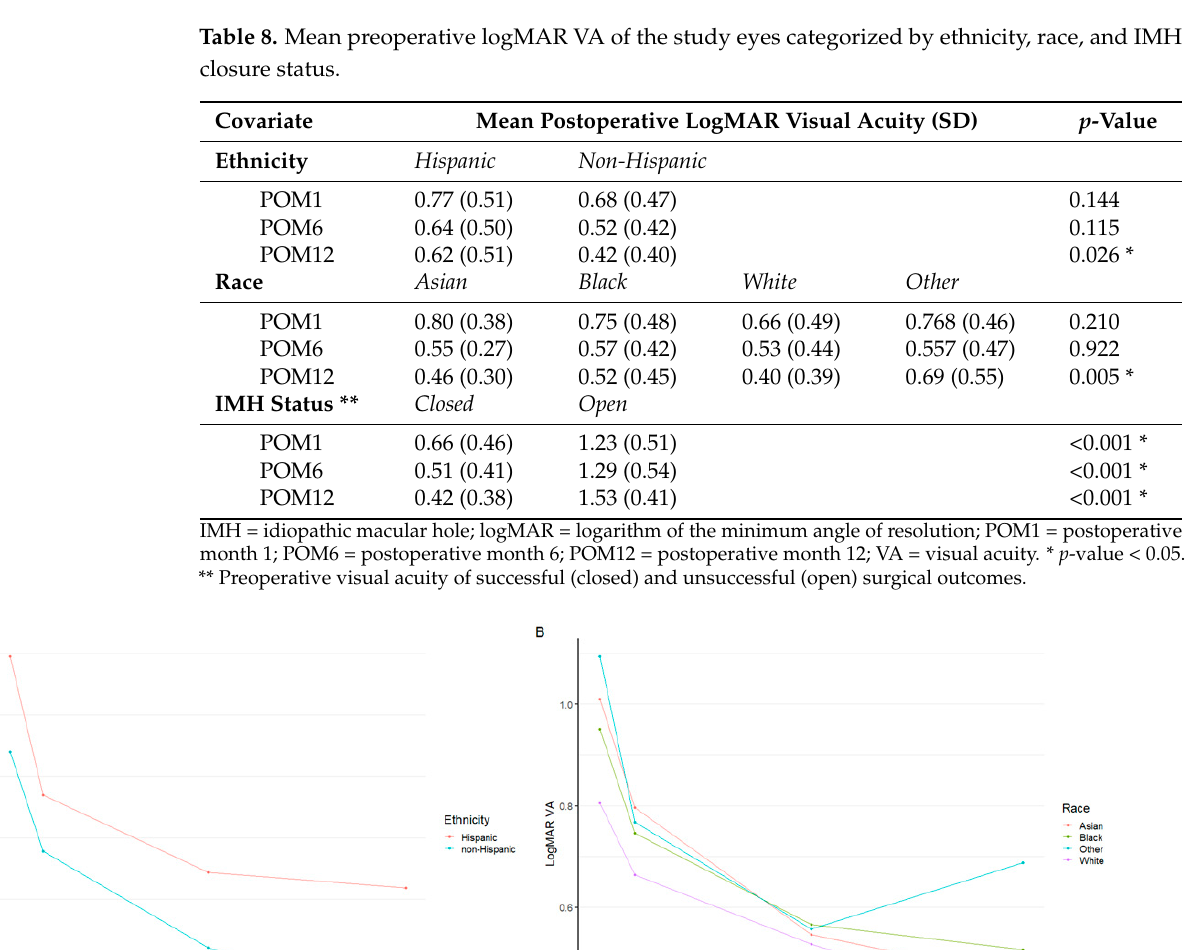
Table 8. Mean preoperative logMAR VA of the study eyes categorized by ethnicity, race, and IMH closure status.